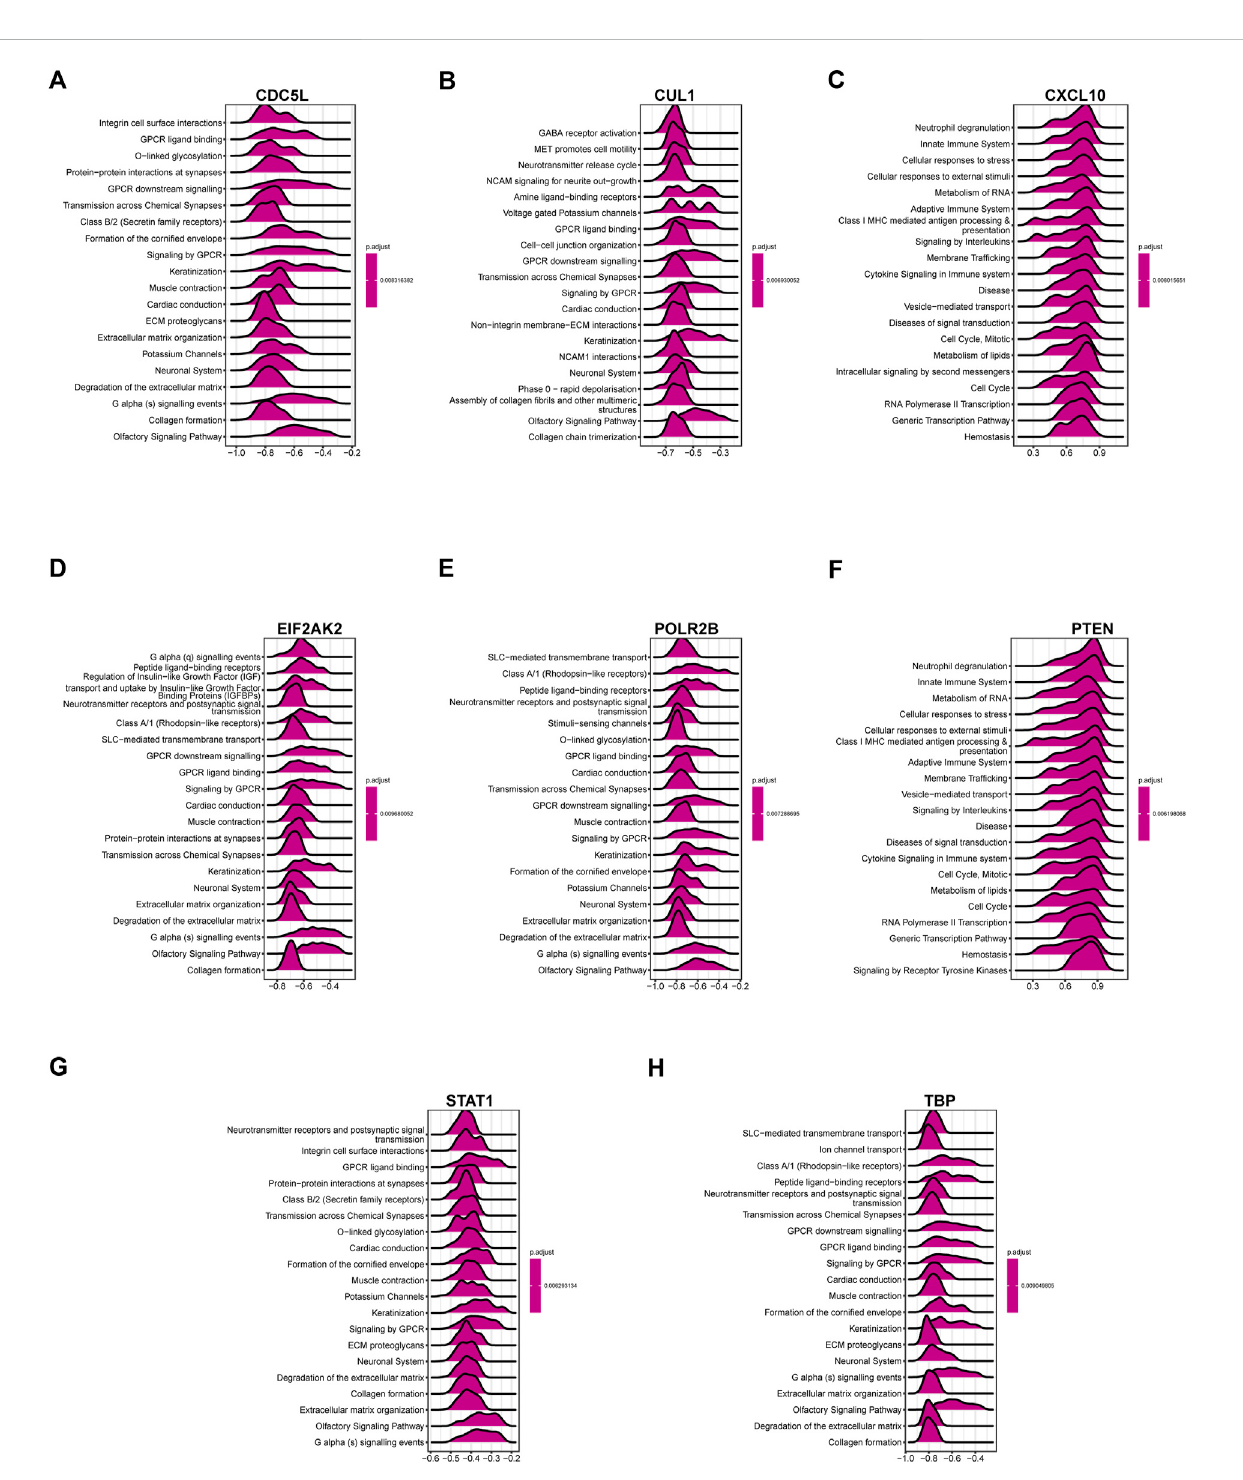
Results ofcorrelation analysis ingeneFigure6wereused for GSEAanalysisofsingle gene. (A) CDC5L, (B) CUL1, (C) CXCL10, (D) EIF2AK2, (E) POLR2B, (F) PTEN, (G) STAT1, (H) TBP.Thetop20resultsof8geneswerepresentedrespectively.TheabscissavaluerepresentstheNESvalueanalyzedbyGSEA.Ifthevalue is greater than 0, the pathway is positively correlated with the gene; if the value is less than 0, the pathway is negatively correlated with the